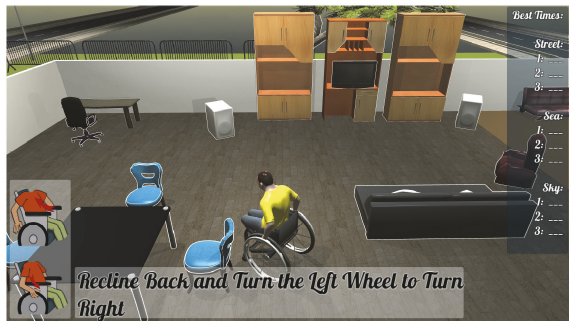
Figure 5: A screen from the developed game with one person playing. The depicted stage is the House , where the character of the game explores the scenario to enter the other